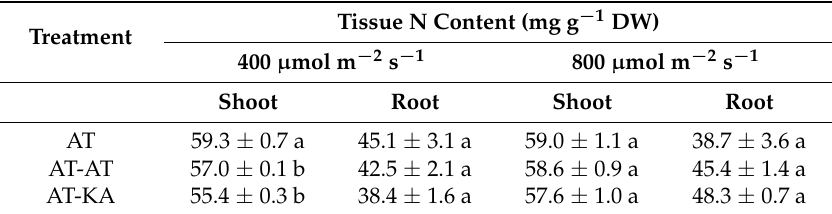
Table 1. Tissue N content in each treatment under medium or high light intensity. Data are means of four biological independent replicates ± SE. Different letters in the same column denote significant differences ( p < 0.05). AT: Non-grafted treatment; AT-AT: Homograft; and, AT-KA: Graft